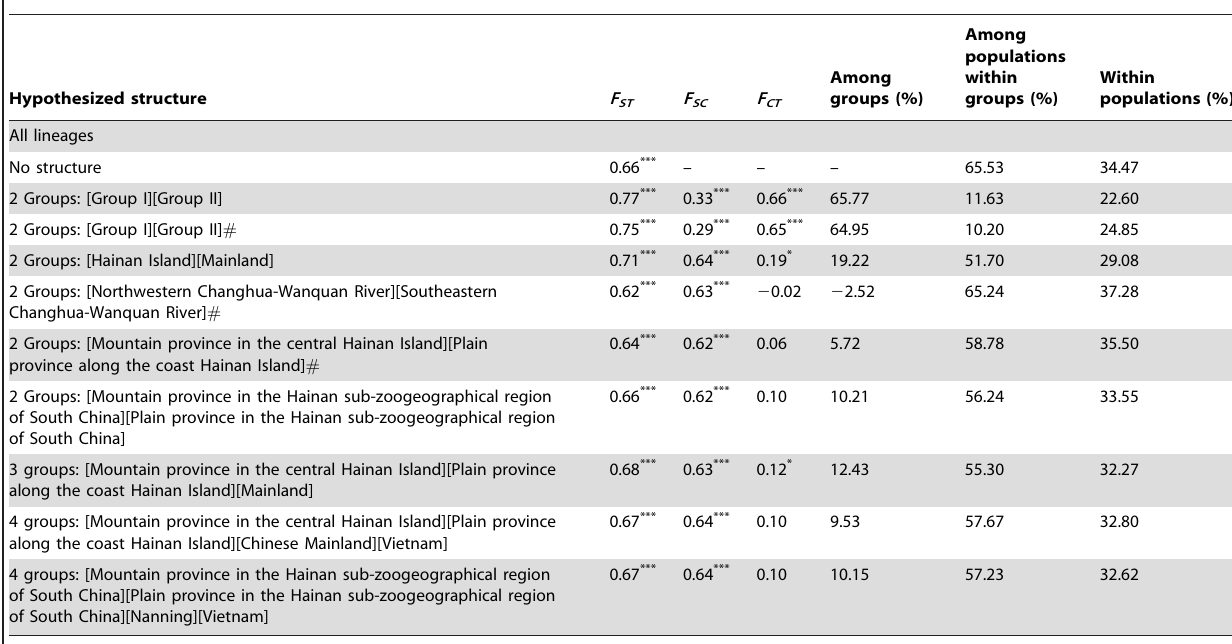
Table 2. Hierarchical analysis of AMOVA of Calotes versicolor .